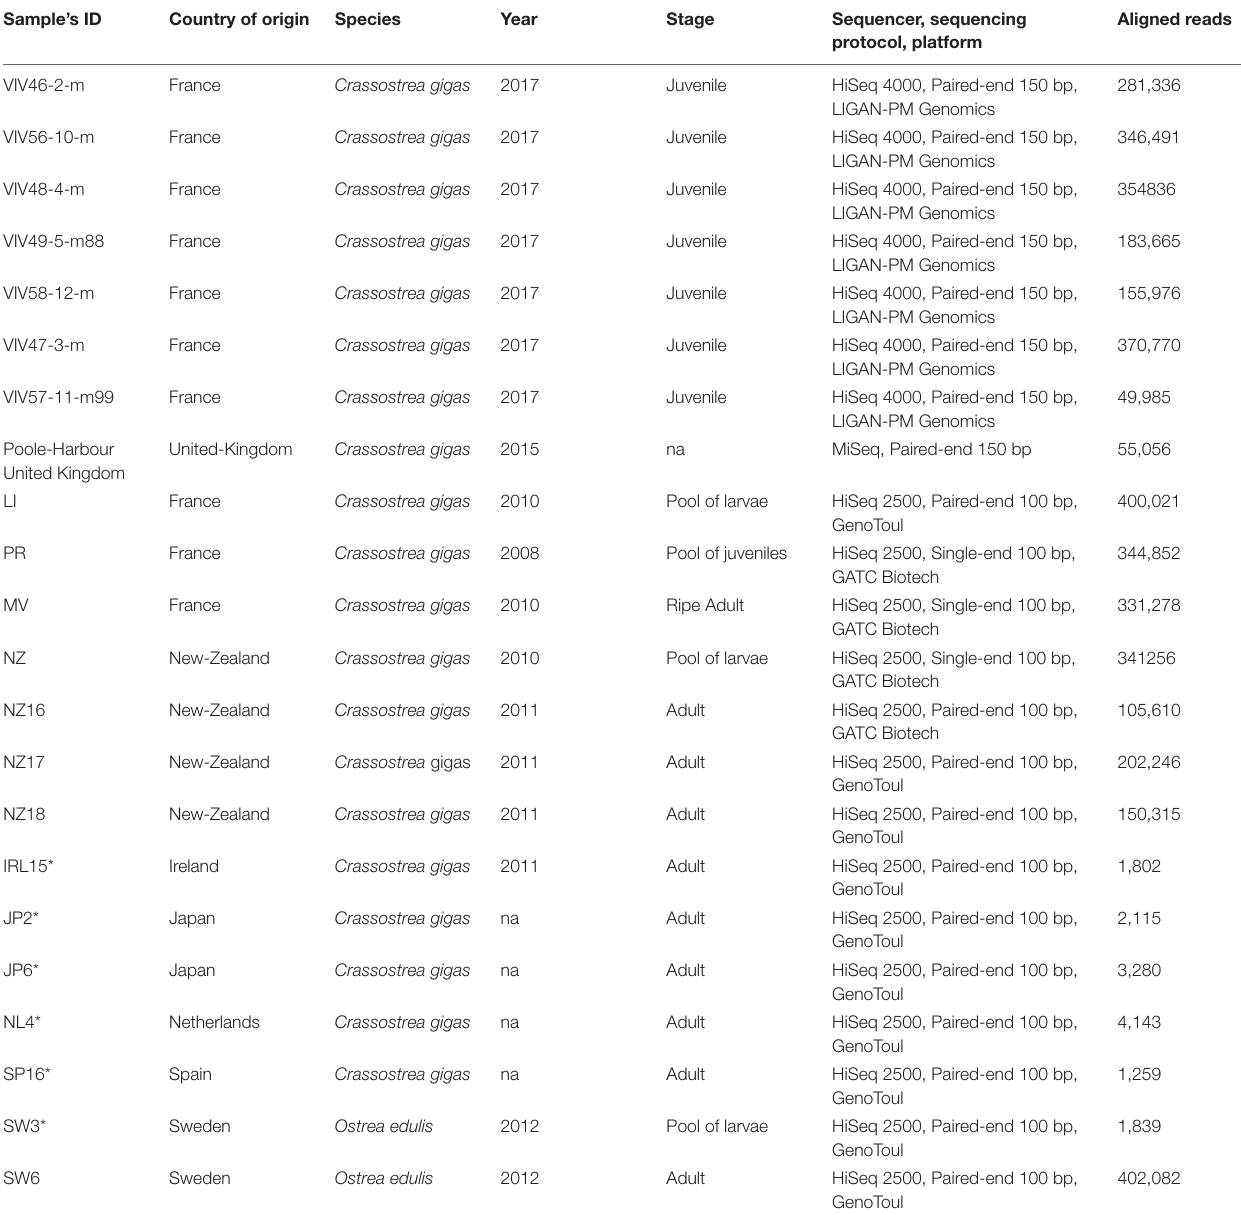
TABLE 1 | Description of the 22 sequenced libraries in this study: country of origin, host species, year of collection, sample stage, sequencing technology, and number of reads aligned against Ostreid herpesvirus 1 ( OsHV-1 ) reference genome (Accession number: NC_005881.2). Sample’s ID Stage Sequencer, sequencing